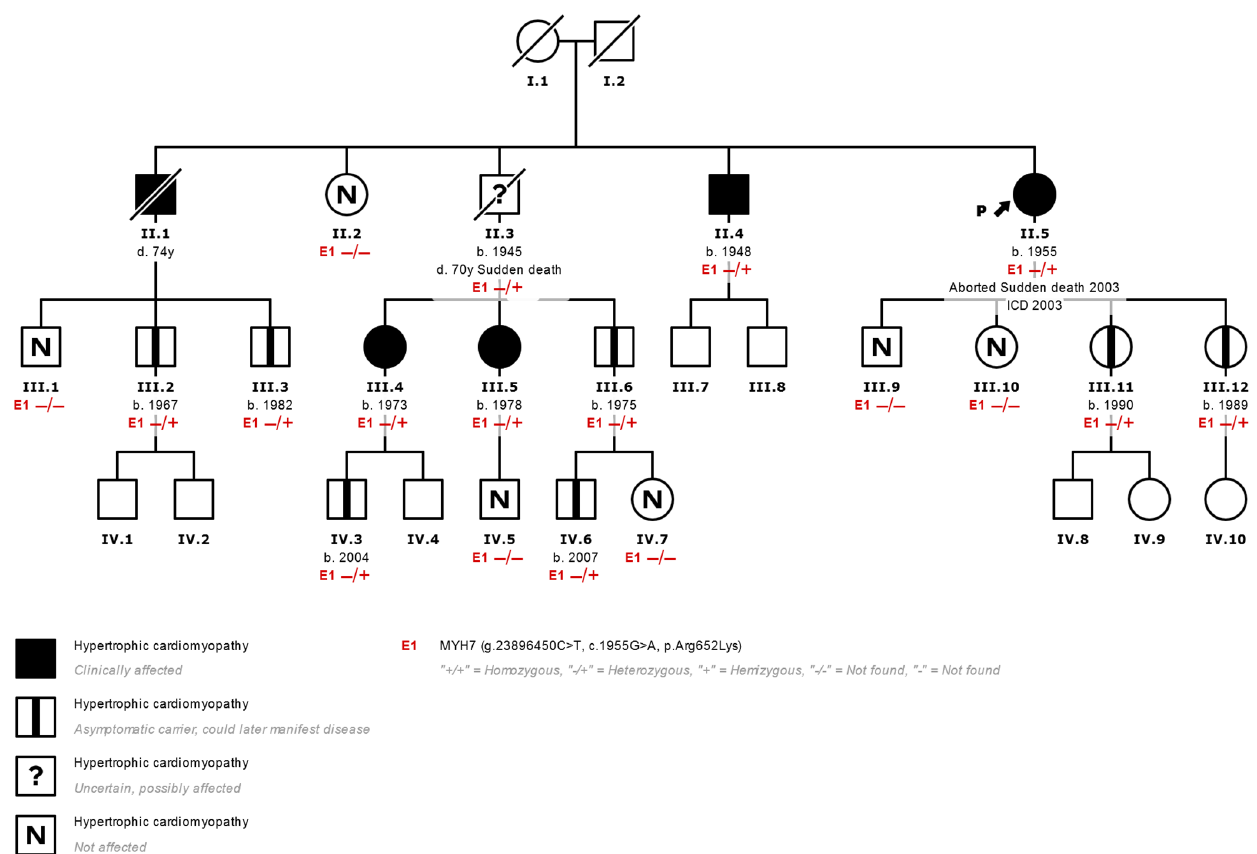
Figure 1. Family tree of a typical family with HCM. (II.5 corresponds to index case N ◦ 7 in Table 1) Most HCMs are inherited in an autosomal dominant fashion. Affected individuals are shown in black, and healthy carriers of the p.Arg652Lys variant (E1) are shown with a central black mark. Using a genetic panel, the variant was identified in the proband (arrow) after an episode of aborted sudden death. Other members of the family who inherited the variant were affected clinically but without severe events such as the proband, which shows variable expressivity of the variant. ICD: